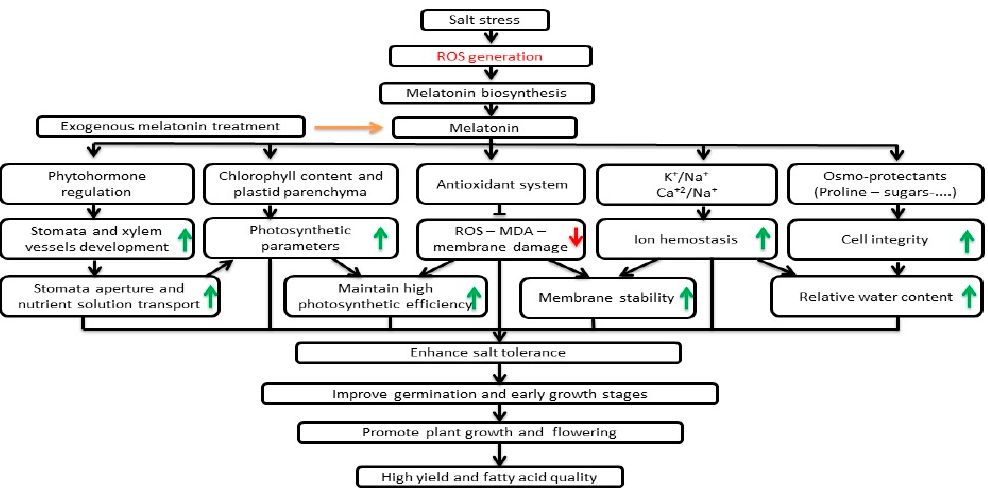
Figure 12. Schematic diagram of mechanisms of melatonin to improve the NaCl stress tolerance, yield,